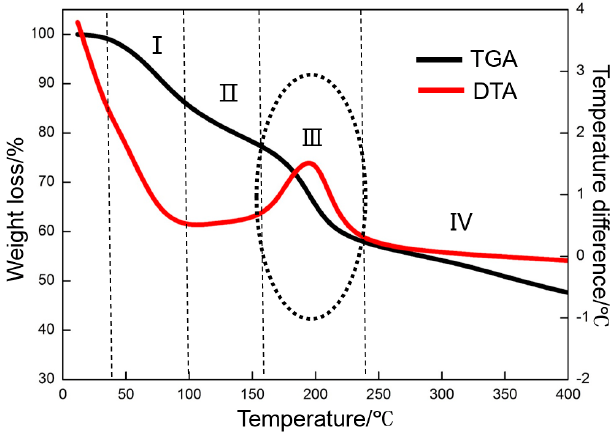
Figure 5. TGA-DTA curves of GO in a nitrogen atmosphere.